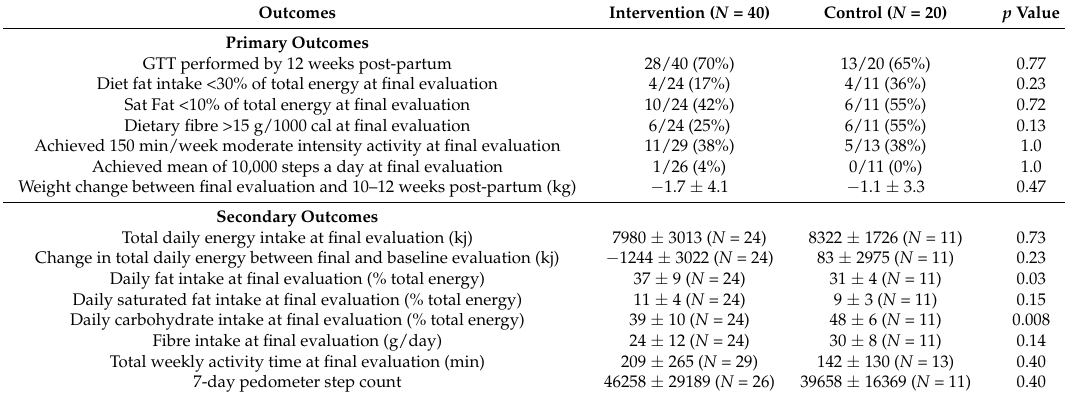
Table 2. Study Outcomes. Data are presented as mean ± SD or proportion (%).